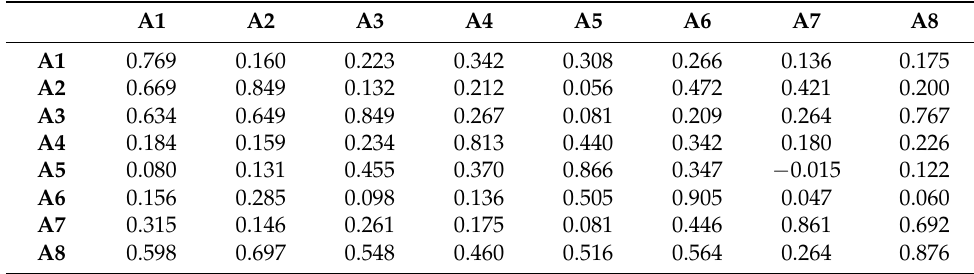
Table 4. Direct relationship matrix of aspects.